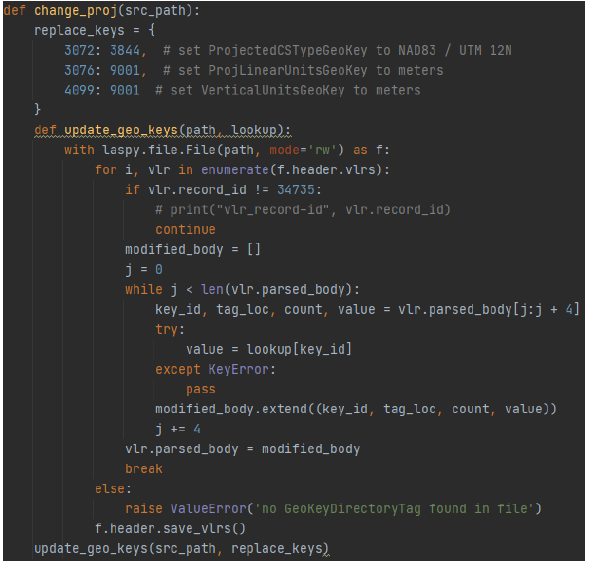
Figure 4 . Python code for projection change